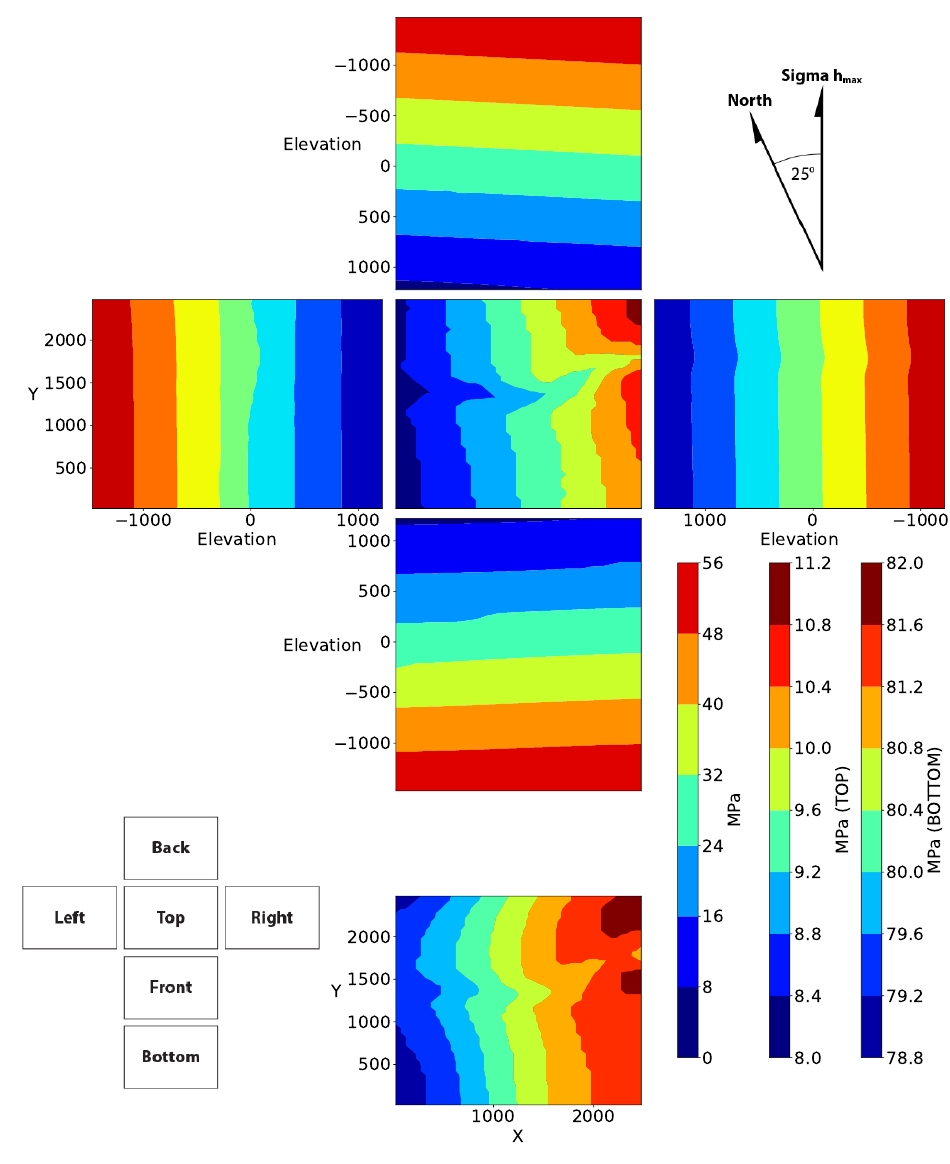
Figure 14. Native state stress distribution. As part of the planning for future injection and production wells at the FORGE site, a number of potential trajectories were evaluated as part of the Phase 2 activities. A full discussion of the well evaluation procedure is beyond the scope of this paper. Here, we focus on providing information on the final selected well trajectory. Figure 15 shows the final selected well trajectory (Well 16A-78(32)) along with an outline of the FORGE site. The well will be located near the center of the FORGE site, with a planned trajectory that travels along an azimuth of N15E, plunging 65 degrees from the vertical. The predicted pressure, temperature, and stress along the planned path of Well 16A-78(32) are shown in Figure